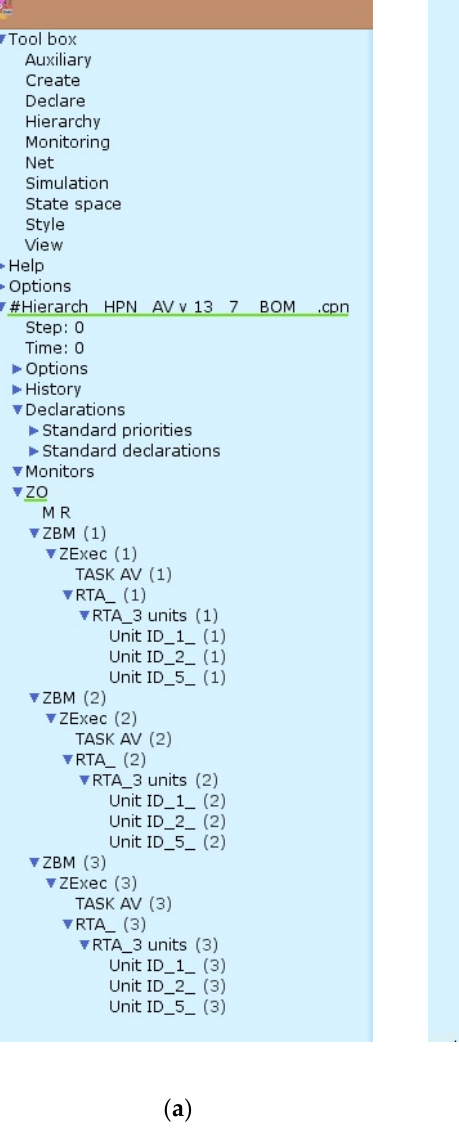
Figure A2. HPN AV model in CPN Tools: ( a ) hierarchical structure; ( b ) declarations.